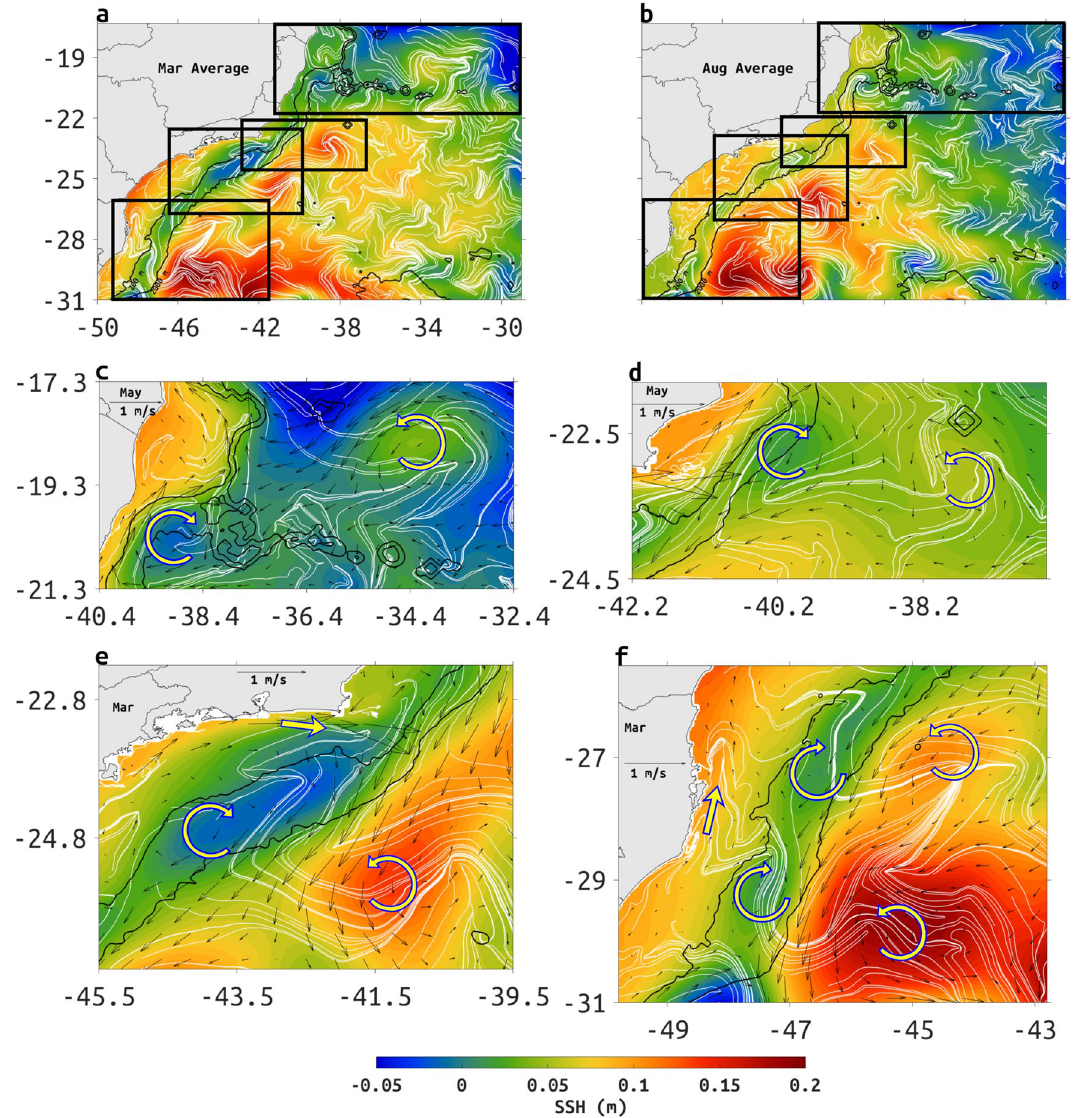
Figure 5. March ( a ) and August ( b ) monthly climatological squeezelines (white lines) over model monthly- mean SSH. Black rectangles indicate regions shown in panels ( c )–( f ). ( c ) Abrolhos Bank region (location 1 in Fig. 3a), ( d ) Cabo de São Tomé (location 6 in Fig. 3a), ( e ) Cabo Frio (location 7 in Fig. 3a) and ( f ) Cabo de Santa Marta (Region 9 in Fig. 3a). The presence of cyclonic and anticyclonic eddies features are highlighted by curved arrows. Straight arrows indicate the direction of coastal jets at upwelling regions. Reference months are indicated at the top left of each map. The vector scale is on the top of each map. Depth contours of 200- and 2000-m are represented by thin black lines. Created with Matlab R2018B (www.mathw